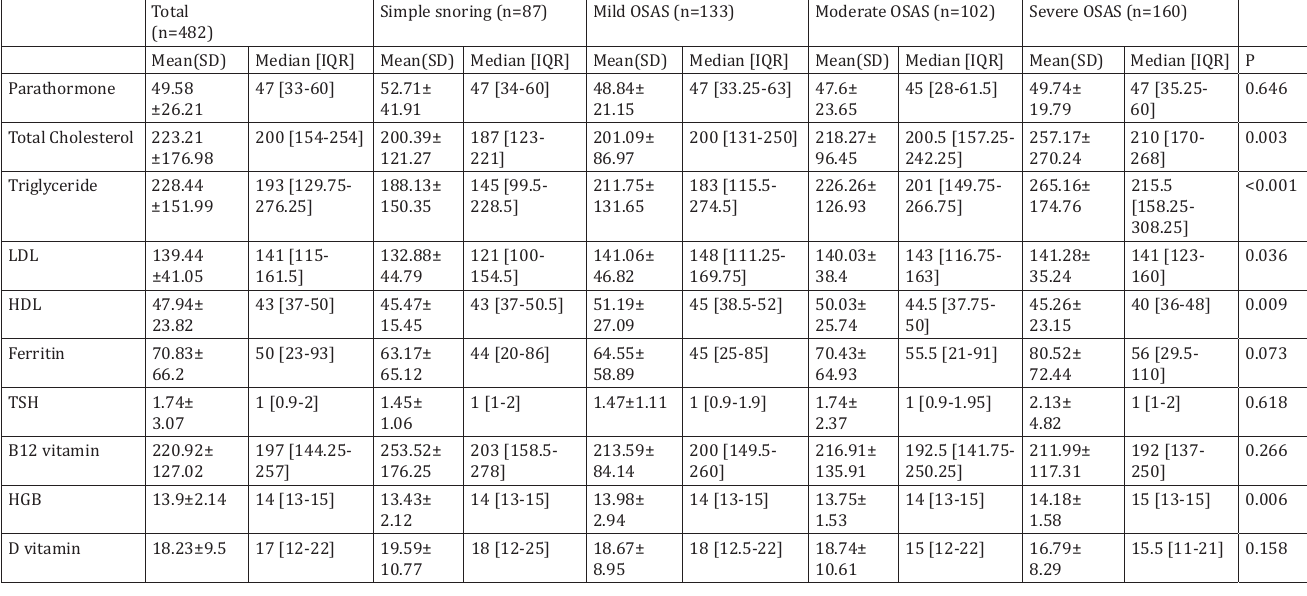
Hemogram and biochemistry values of study subjects according to the severity of